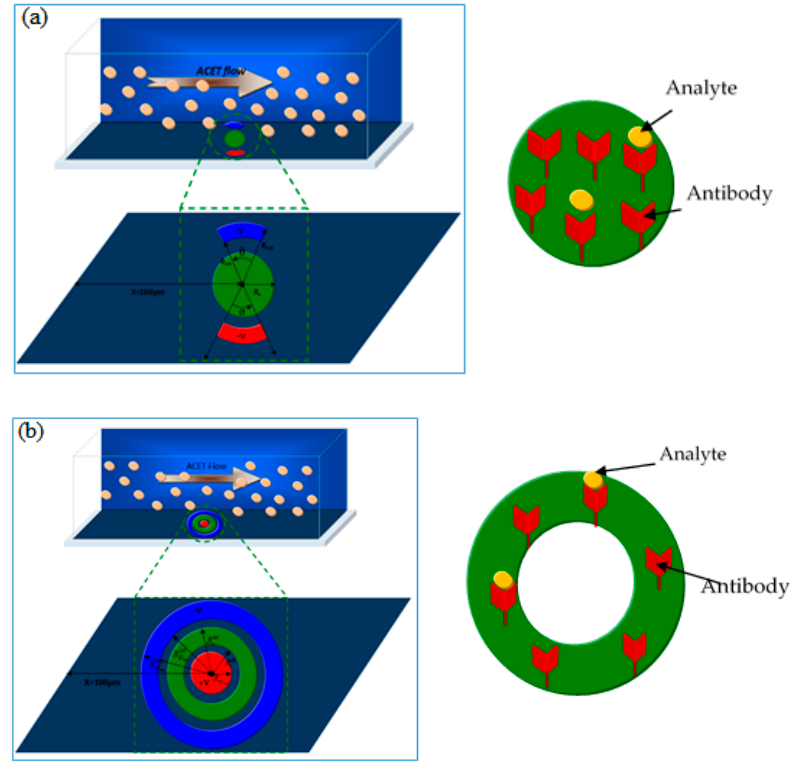
Figure 1. Sketch of two types of 3D models of a microfluidic biosensor. The channel dimensions (length, width, and height) are respectively 250 µ m, 50 µ m, and 40 µ m. ( a ) Geometry 1; ( b ) Geometry 2.